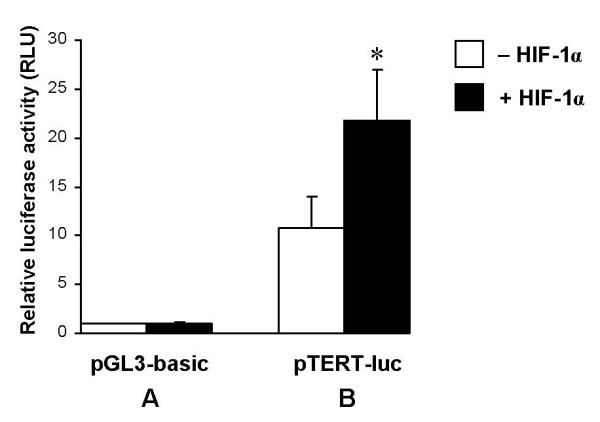
Effect of omHIF-1α overexpression on omTERT promoter activity. CHO Ka13 cells were transiently transfected with 600 ng of a luciferase reporter vector containing 3.5 kb of omTERT 5'-flanking sequence (pTERT-luc; panel B) or 600 ng of empty reporter vector (pGL3-basic; panel A) along with 100 ng of pCMV-omHIF-1α (solid bar) or 100 ng of the empty pCMVTNT vector (open bar) and 100 ng of the pTracer-EF/Bsd/lacZ (β-galactosidase) expression vector. Relative luciferase activity (RLU) is the ratio of luciferase over β-galactosidase activity. Data are the mean ± SD of three independent experiments. Asterisk (*) indicates significant effect (p < 0.001) of omHIF-1α overexpression on induction of pTERT-luc activity.